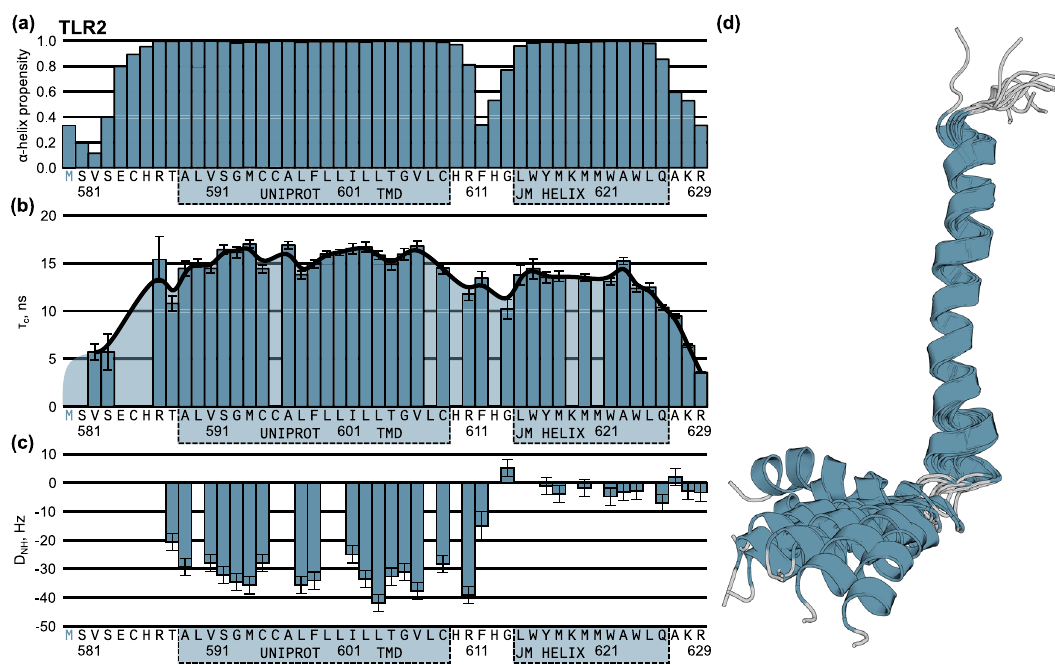
Fig. 2 | Spatial structure of TLR2tmjm in DMPC/DMPG/DHPC bicelles (DMPC:DMPG=4:1). a The probability of α -helix conformation of the amino acid residues,accordingtothechemicalshiftanalysis. b Valuesof τ C ,correlationtimeof rotational diffusion, for the individual amide groups of the amino acid residues. c Magnitudes of residual dipolar couplings ( 1 D NH ). The sequence is numbered according to UNIPROT. The blue boxes denote the parts of TLR2tmjm: the region